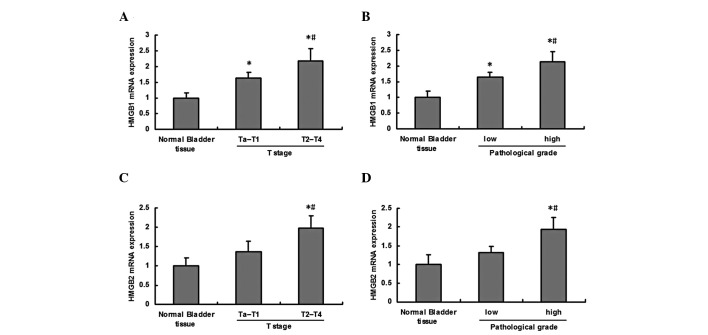
Real-time polymerase chain reaction (PCR) analysis of high mobility group box 1 (HMGB1) and HMGB2 mRNA expression in bladder carcinoma (BCa). (A) HMGB1 mRNA expression in BCa with different tumor (T) stages. (B) HMGB1 mRNA expression in BCa with different pathological grades. (C) HMGB2 mRNA expression in BCa with different T stages. (D) HMGB2 mRNA expression in BCa with different pathological grades. *P<0.05 vs. normal bladder urothelium, #P<0.05 vs. Ta-T1 stage or low pathological grade.